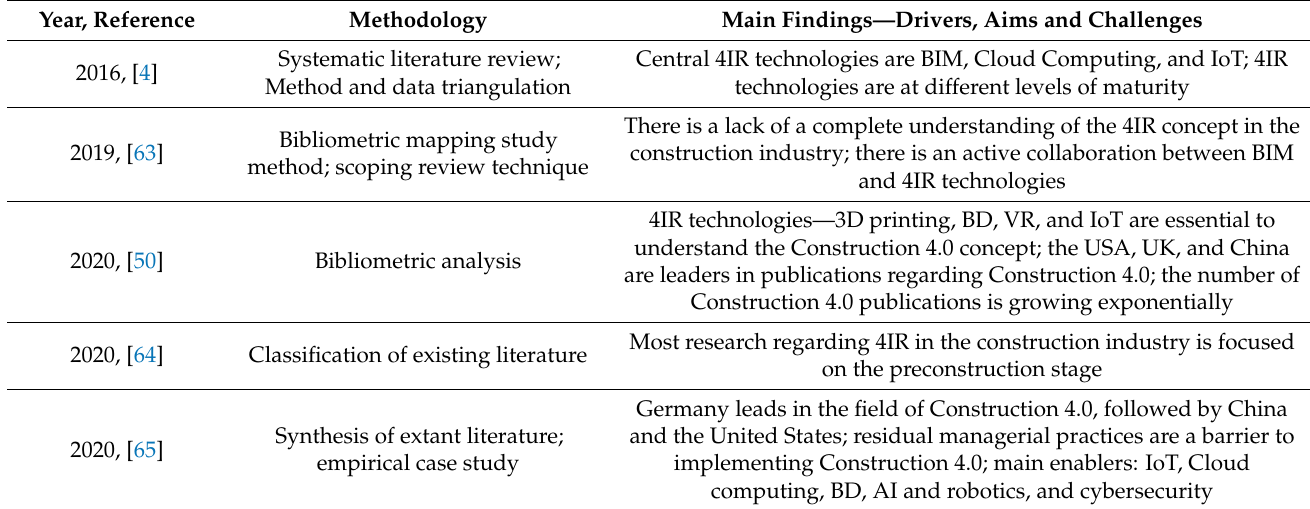
Table 2. Chronological findings and applied methodologies of Construction 4.0